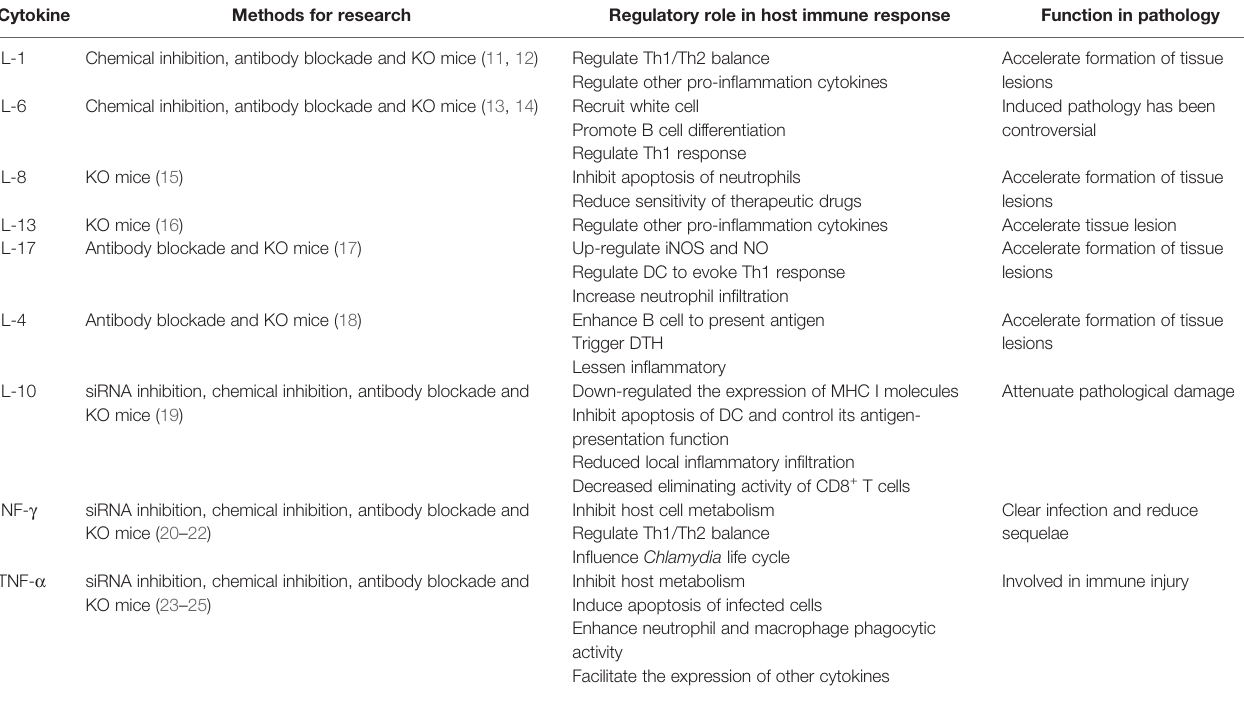
TABLE 1 | Function of cytokines in pathological changes during Chlamydia